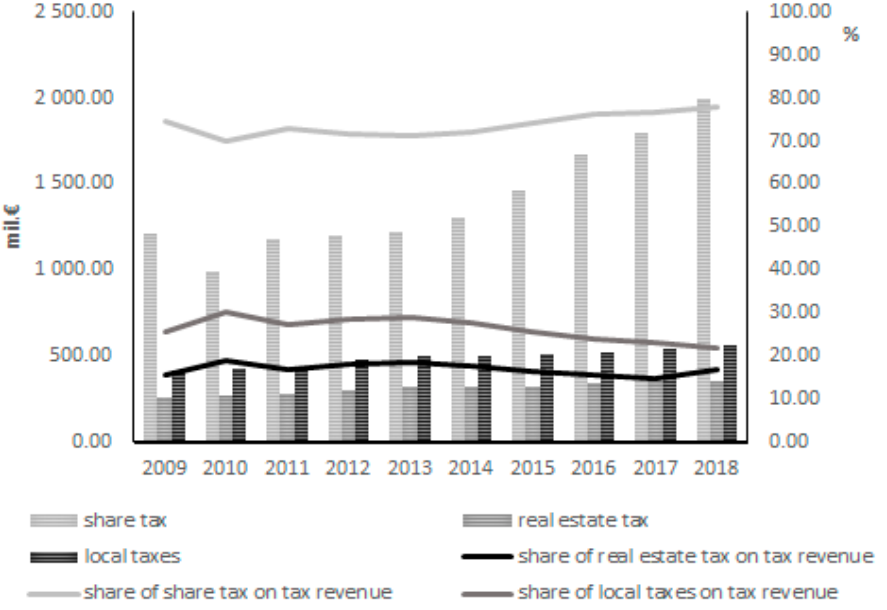
Figure 5. The share of individual categories of tax revenues of the municipalities in Slovak Republic in the time period 2009–2018, Source: Ministry of Finance of Slovak Republic, own processing.